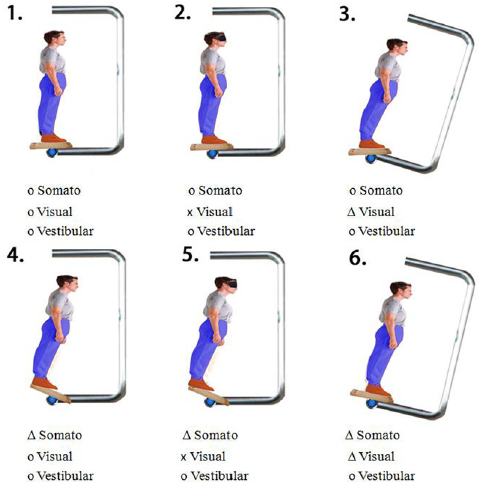
Fig 2. Six sensory conditions. o: Correct; x: Removed; 4 :Misleading sensory